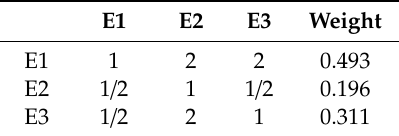
Table A12. Pairwise comparison matrix of rural environment indicators.